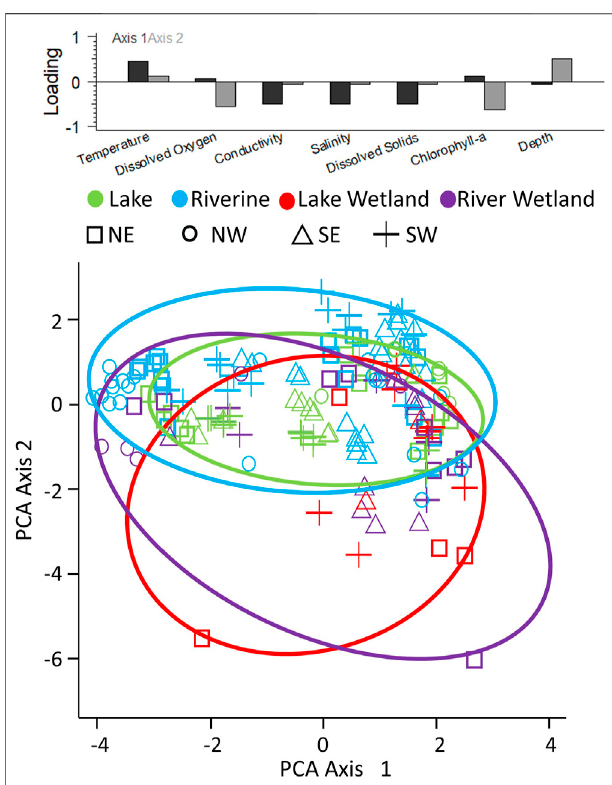
FIGURE3| PrincipalComponentsAnalysisplot,withthetwomajoraxes depicted. Points are color-coded by habitat type and different point types show differentregions. Ellipsesaredrawn toencompass allpoints withineach habitat type and are color-coded to match the points. The top plot shows the loading of each variable on each of the two major